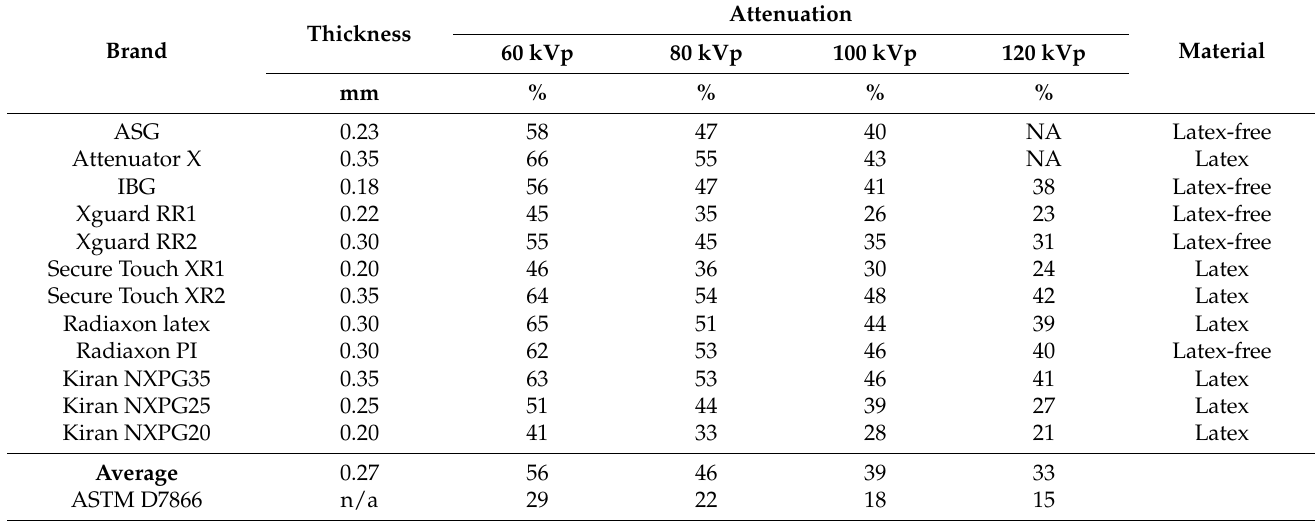
Table 5. Brand, thickness, attenuation efficiency (AE), and material of the radiation attenuation gloves on the market that are lead-free. Latex-free gloves are made of synthetic elastomers. AE is compared to the radiation-attenuating glove standard ASTM D7866 [50] minima.